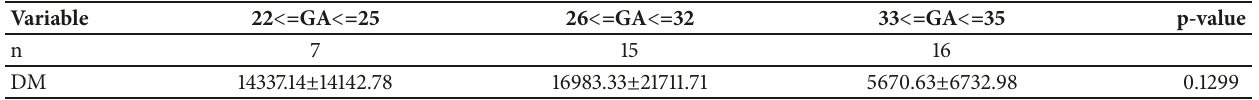
Table 3: Mean ( ± standard deviation) of donor milk according to gestational age